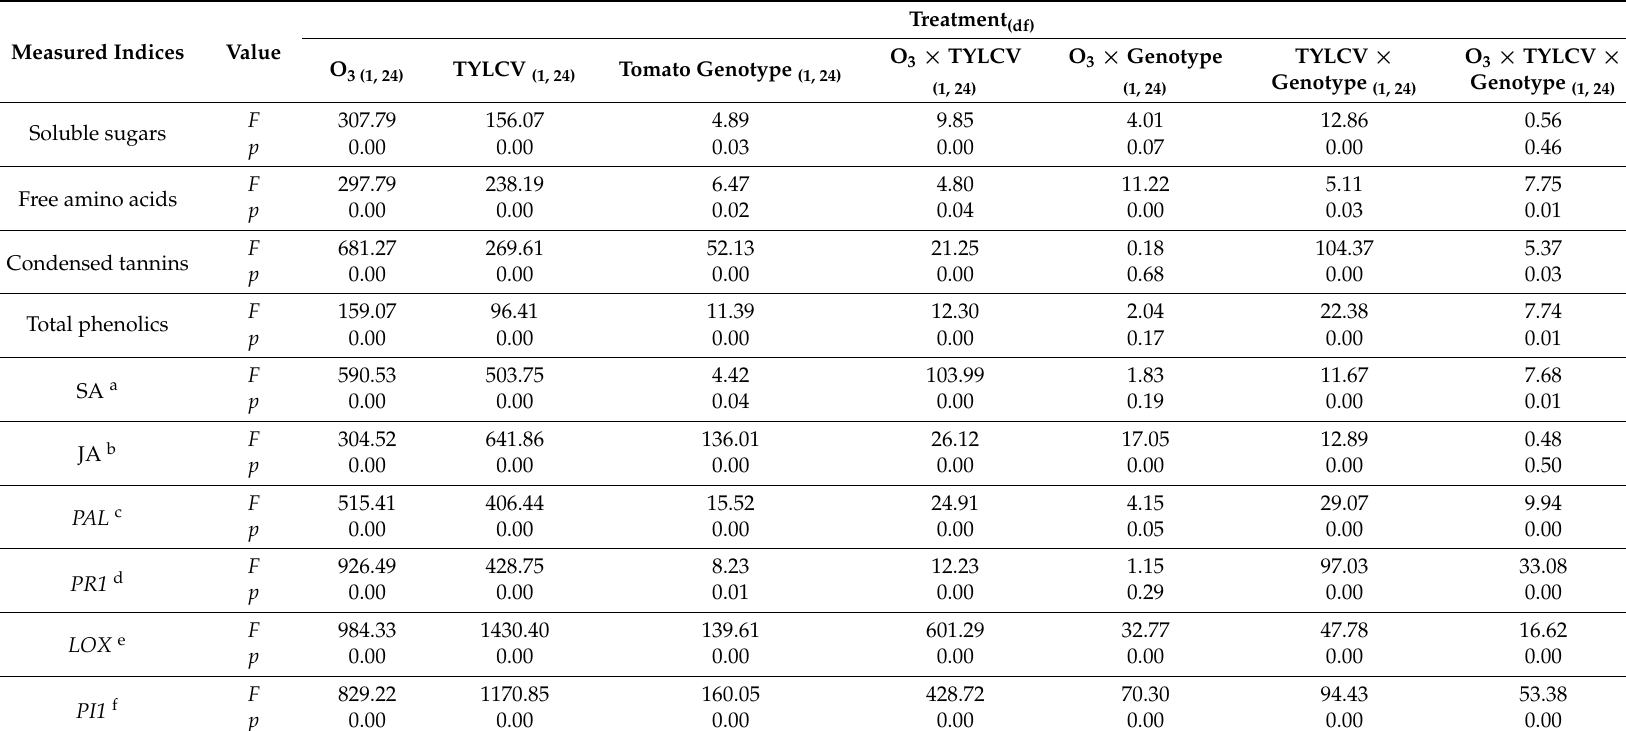
Table 2. Effects of O 3 level, TYLCV infection, and plant genotype on biochemical properties of tomato. F and p values from ANOVA are